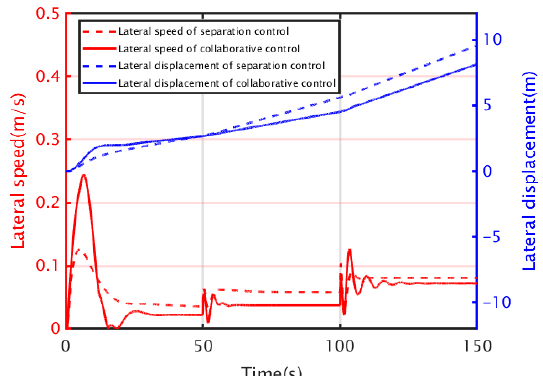
Figure 8. Comparison curves of lateral speed and lateral displacement for sidewind sailing.